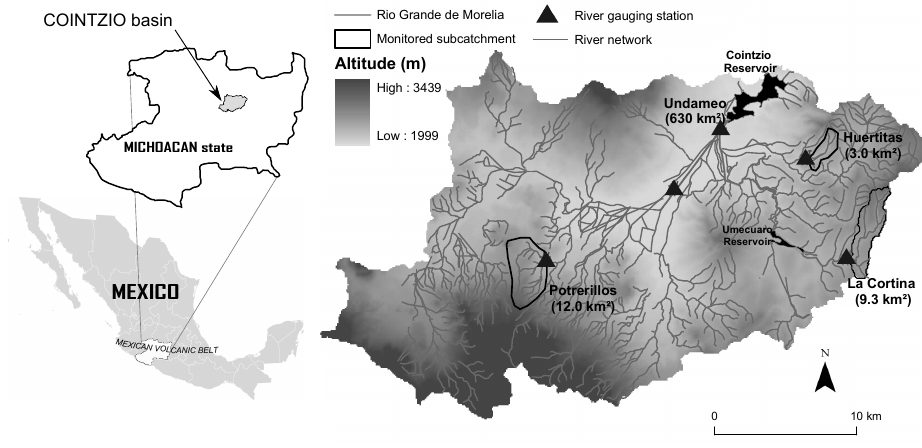
Fig. 1. Location of the Cointzio basin and its four monitored stations (Huertitas, Potrerillos, La Cortina and